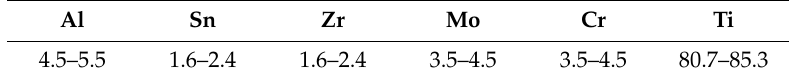
Table 1. TC17 (Ti-5Al-2Sn-2Zr-4Mo-4Cr ) titanium alloy chemical composition (wt